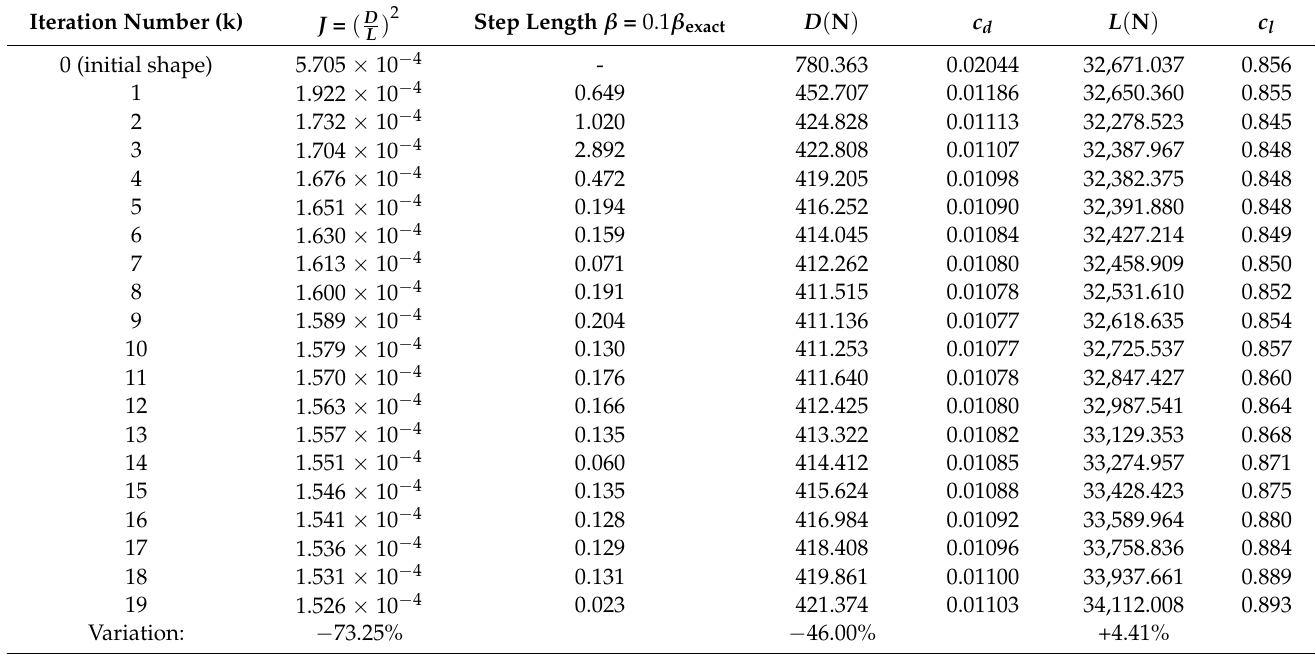
Table 5. Results for Test case II.